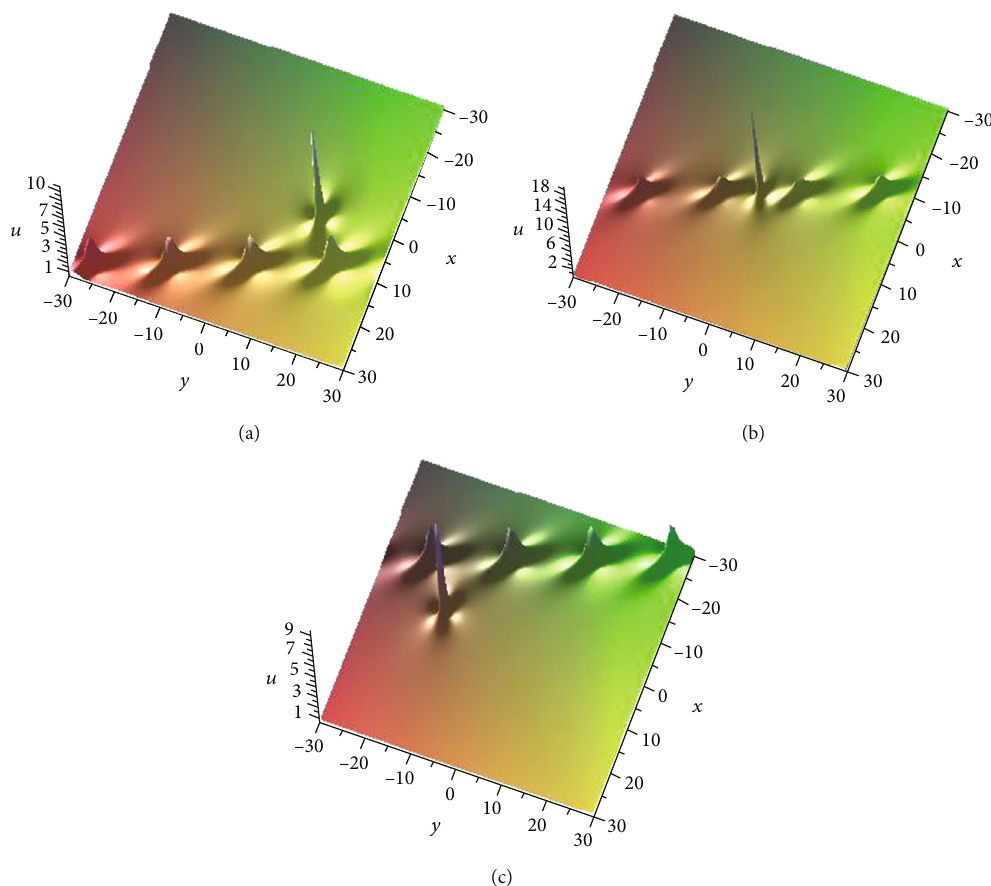
Figure 7: Propagation of hybrid solution composed of a breather and a lump at di ff erent times: (a) n = − 20 , (b) n = 0 , and (c) n = 20